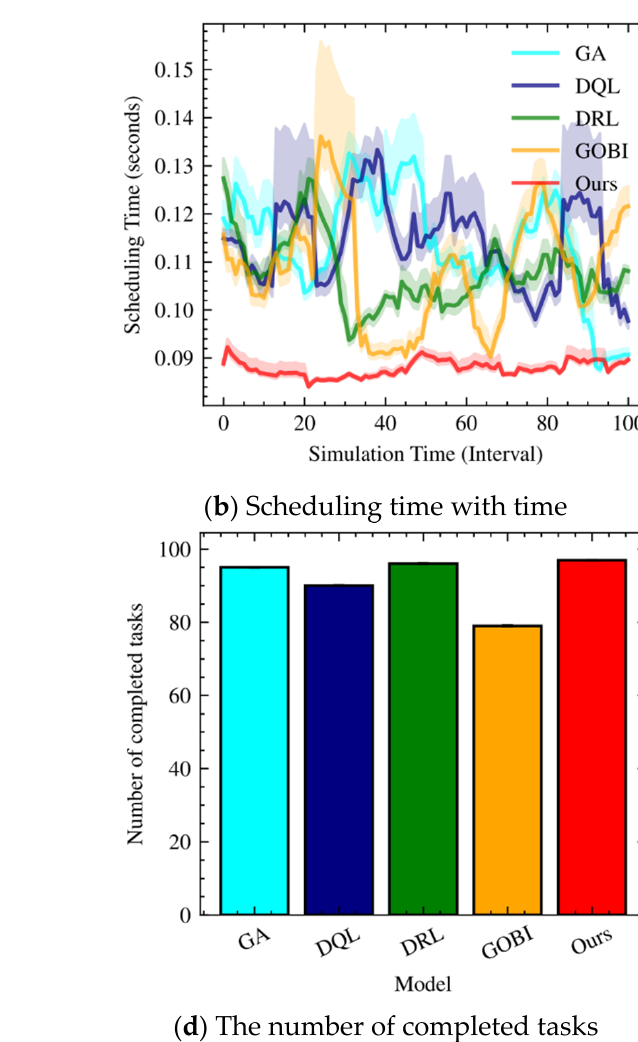
Figure 4. Scheduling time, the number of migrations, and the number of completed tasks with ten hosts.